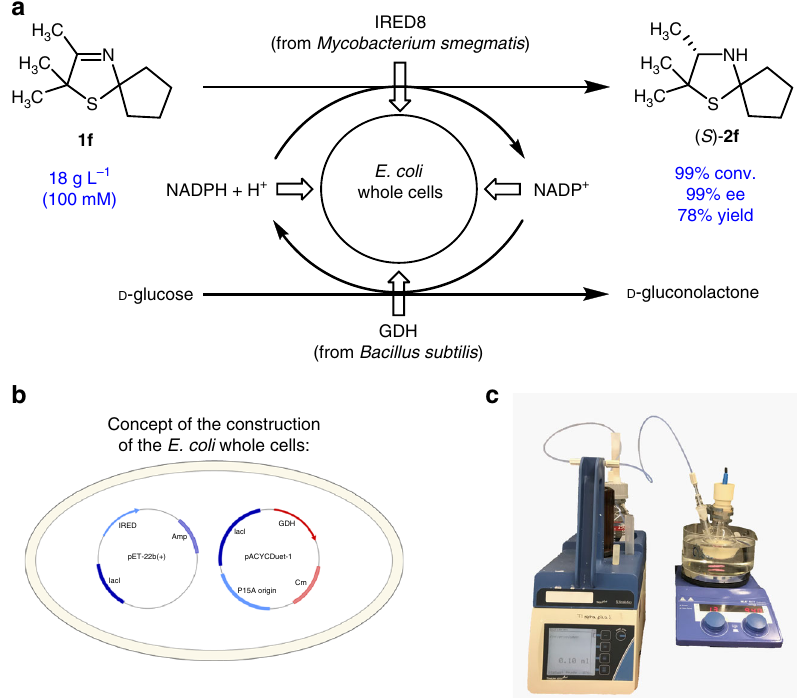
Fig. 7 Process development on 3-thiazoline reduction. a Whole-cell catalyzed reduction of 3-thiazoline 1f on 18 g L − 1 scale, which corresponds to a substrate concentration of 100 mM. After 30 h of reaction time ( S )- 2f was obtained with 99% conversion (conv.) and 99% enantiomeric excess (ee) and was isolated with 78% yield. b Design of the recombinant whole-cell catalyst, containing imine reductase (IRED) from Mycobacterium smegmatis in a pET22b( + ) vector and glucose dehydrogenase (GDH) from Bacillus subtilis in a pACYCDuet-1 vector. c Reaction setup for preparative scale